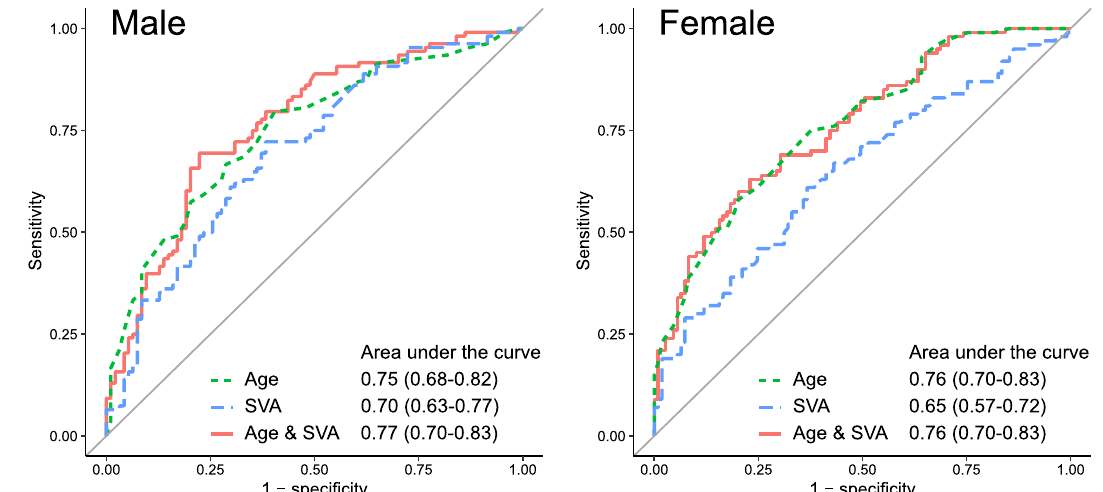
Figure 2. Receiver operating characteristic curves of cognitive decline prediction based on age and/or sagittal vertical axis. SVA sagittal vertical axis.